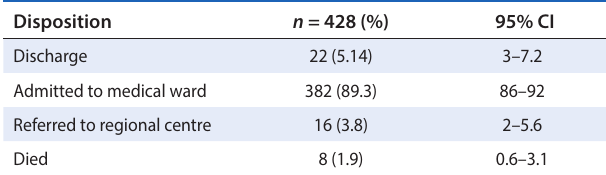
Table 4: Disposition of patients from the ED